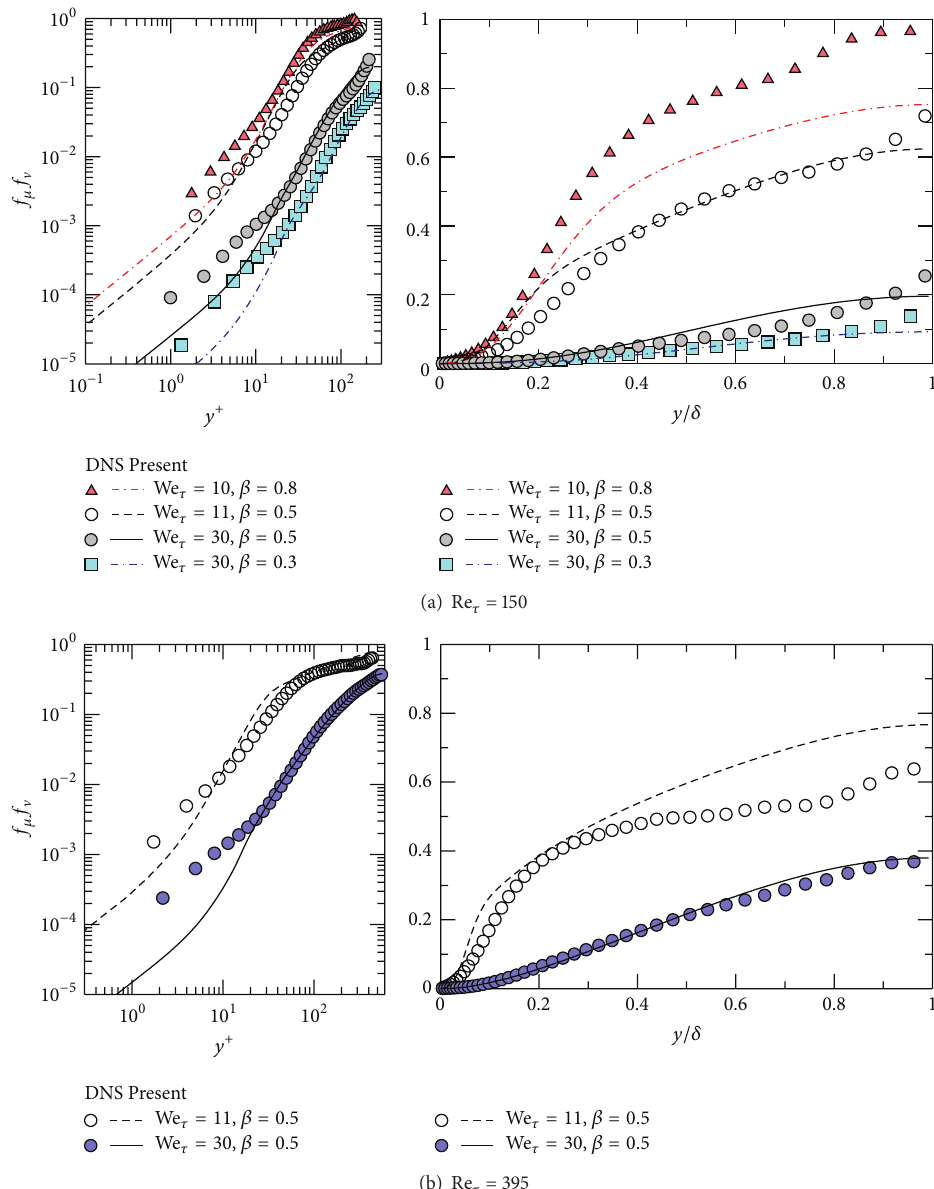
Figure 14: Validation of damping function, the product of 𝑓 𝜇 and 𝑓 V